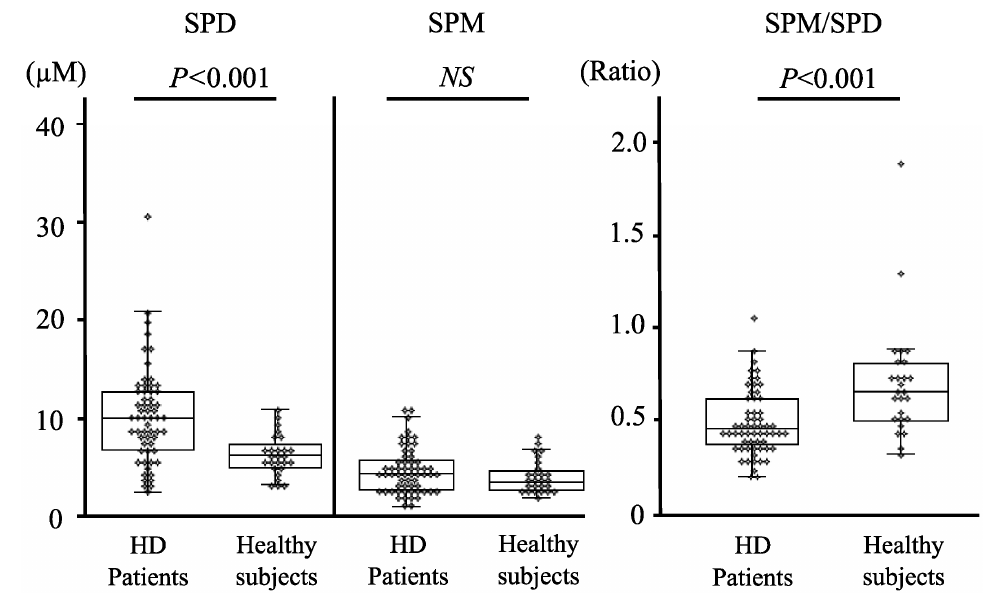
Figure 1. A box and whisker plot and scatterplot of whole blood SPD, SPM, and SPM/SPD in dialysis patients and healthy participants. For each box, the interior line shows the median, and the edges of the box are the estimates of the first and third quartiles. The whiskers extend to the most extreme data points not considered outliers (1.5 times the interquartile range from the edges of the box). Black dots indicate the values for each patient. Left: Comparison of whole-blood SPD and SPM levels in dialysis patients and healthy participants. Right: Comparison of whole blood SPM/SPD between dialysis patients and healthy participants. SPD: Spermidine, SPM: Spermine, HD: hemodialysis, NS: not significant.